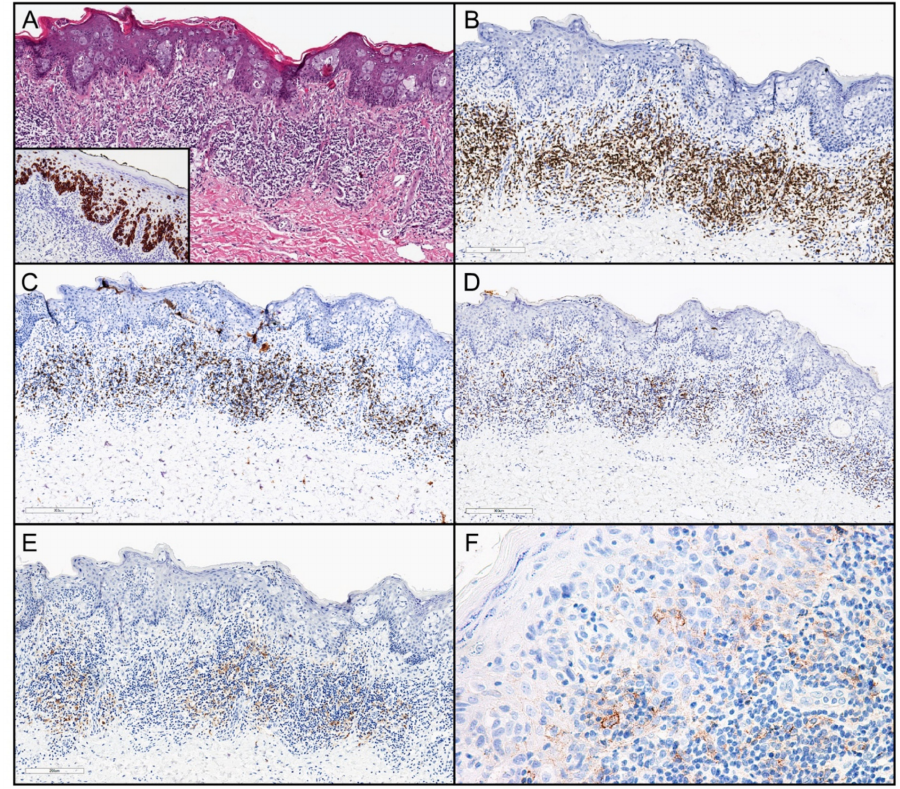
Figure 1. Immune infiltrate associated with extramammary Paget disease (EMPD). ( A – E ) Representative hematoxylin-eosin-stained sections showing ( A ) intraepithelial tumor component (100 × ) (inset, cytokeratin-7 immunohistochemical (IHC) study highlighting EMPD tumor cells; 100 × ) and ( B ) CD3 + lymphocytes (100 × ), ( C ) CD8 + lymphocytes (100 × ), ( D ) PD-1 + lymphocytes (100 × ), and ( E ) PD-L1 + lymphocytes (100 × ) in the tumor-associated immune infiltrate. ( F ) Weak and predominantly partial membranous expression of PD-L1 in EMPD tumor cells (200 × ), shown for comparison (1–2 +